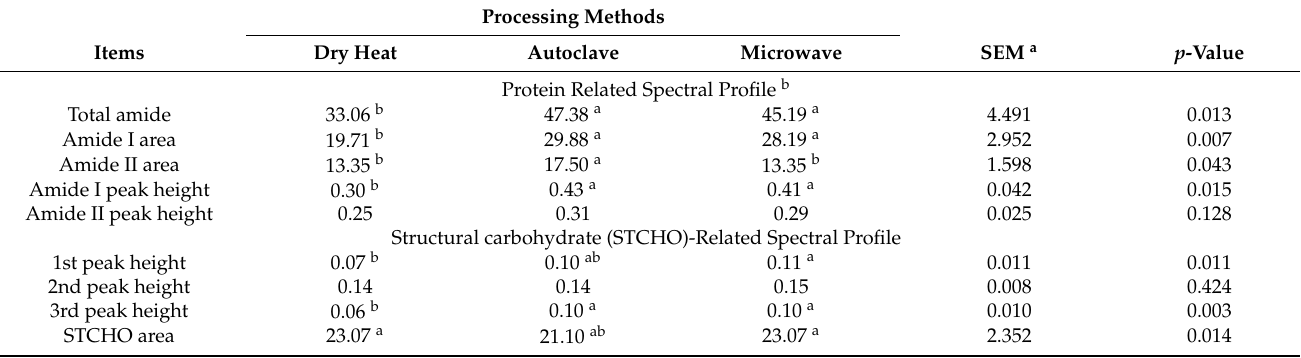
Table 2. Cool-Climate Adapted CDC Genotypes of Chickpeas Grown in Western Canada: Protein and carbohydrate molecular structures spectral profiles (A.U. Unit) of different thermal processing methods using Fourier-transform infrared attenuated total reflectance molecular